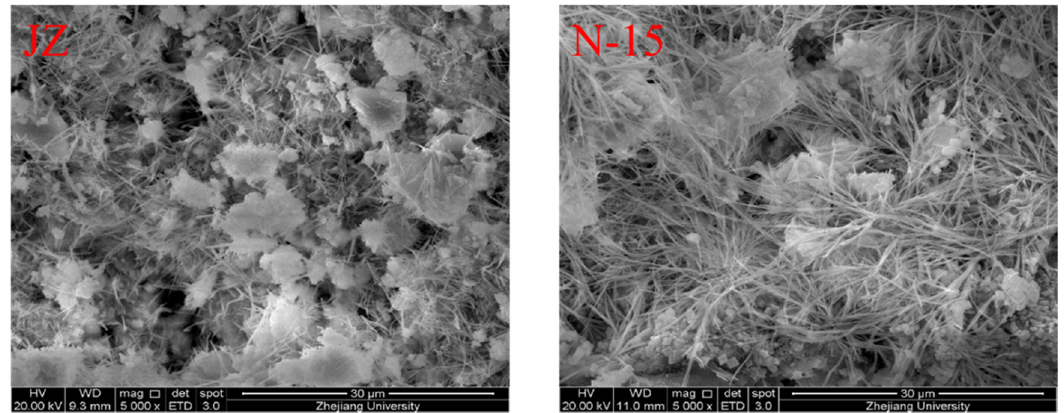
Figure 7: SEM images of specimens at 1